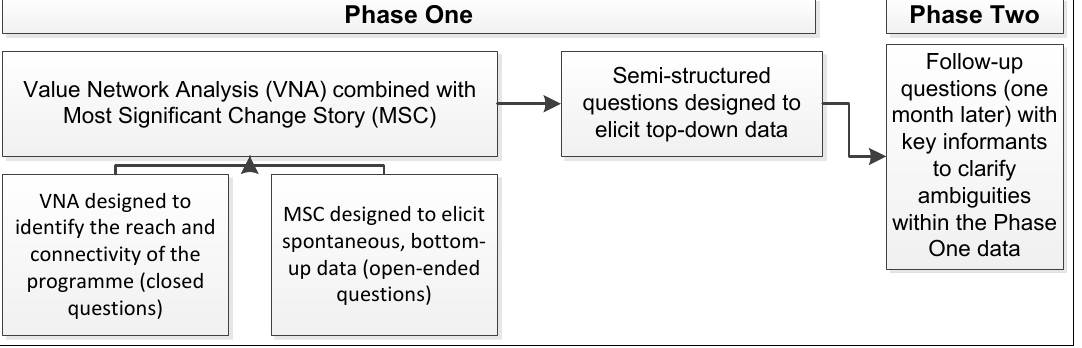
Figure 3: An overview of the research methodology. Source: authors' contribution The methodological design was intended to elicit bottom-up and top-down information. The details of the approaches are provided